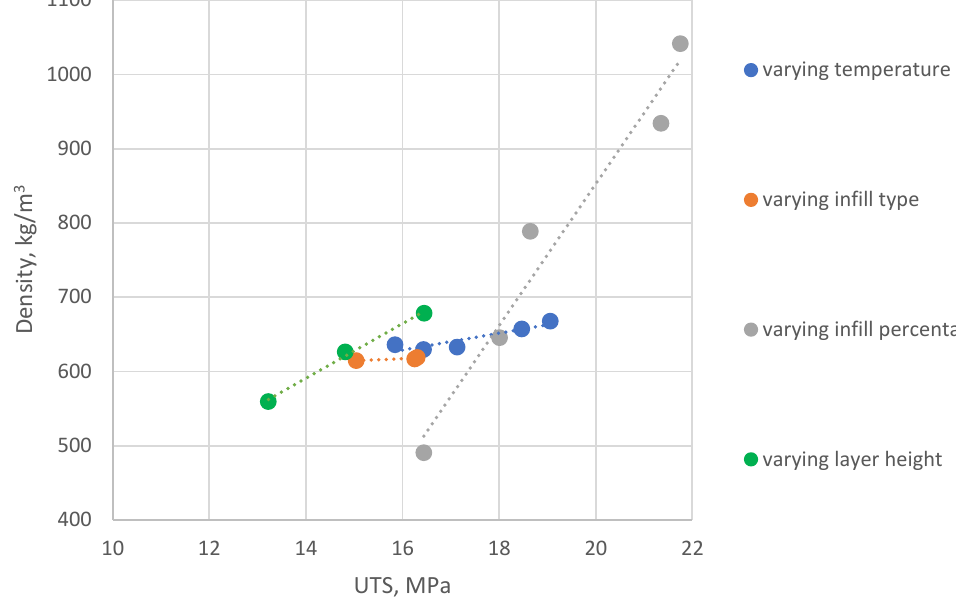
Figure 4. Graphical representation of UTS vs. specimens’ density measured data (PET-G): varying temperature — sets No. 1 – 5; varying infill type — sets No. 6 – 8; varying infill percentage — sets No. 9 – 13; varying layer height — sets No. 14 – 16.